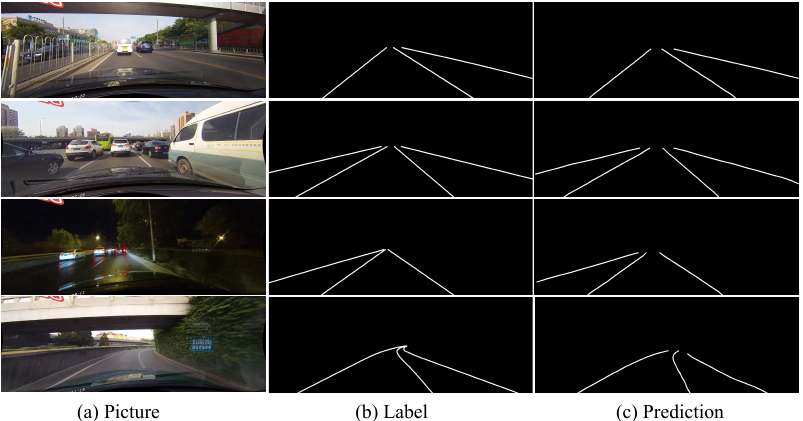
Figure 2. The lane detection results of our network in a variety of complex traffic scenarios on CULane